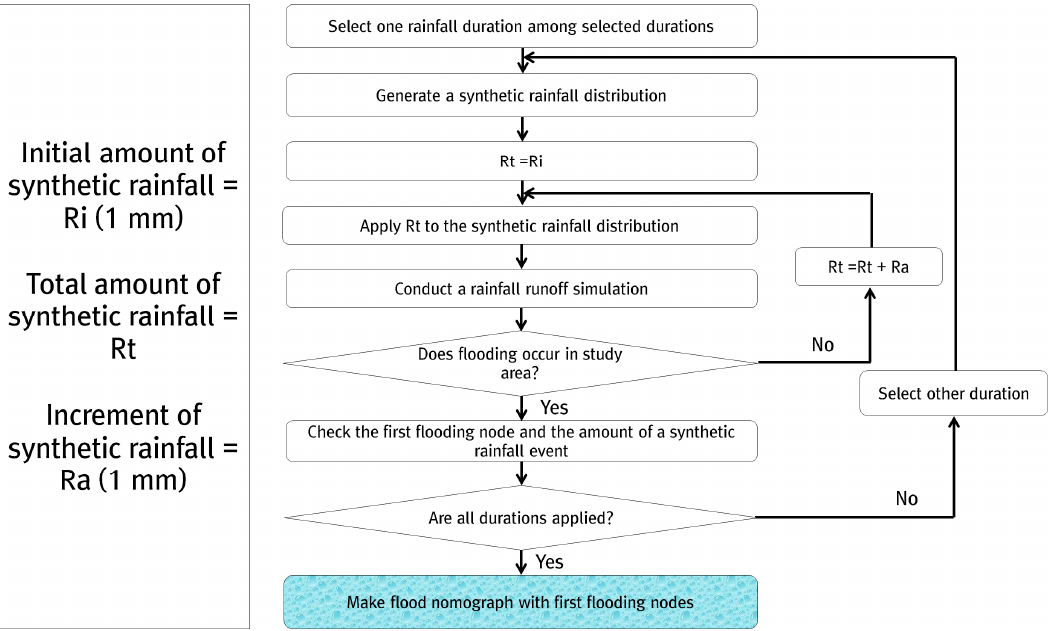
Figure 2. Flow chart for making a flood nomograph with the first flooding nodes.